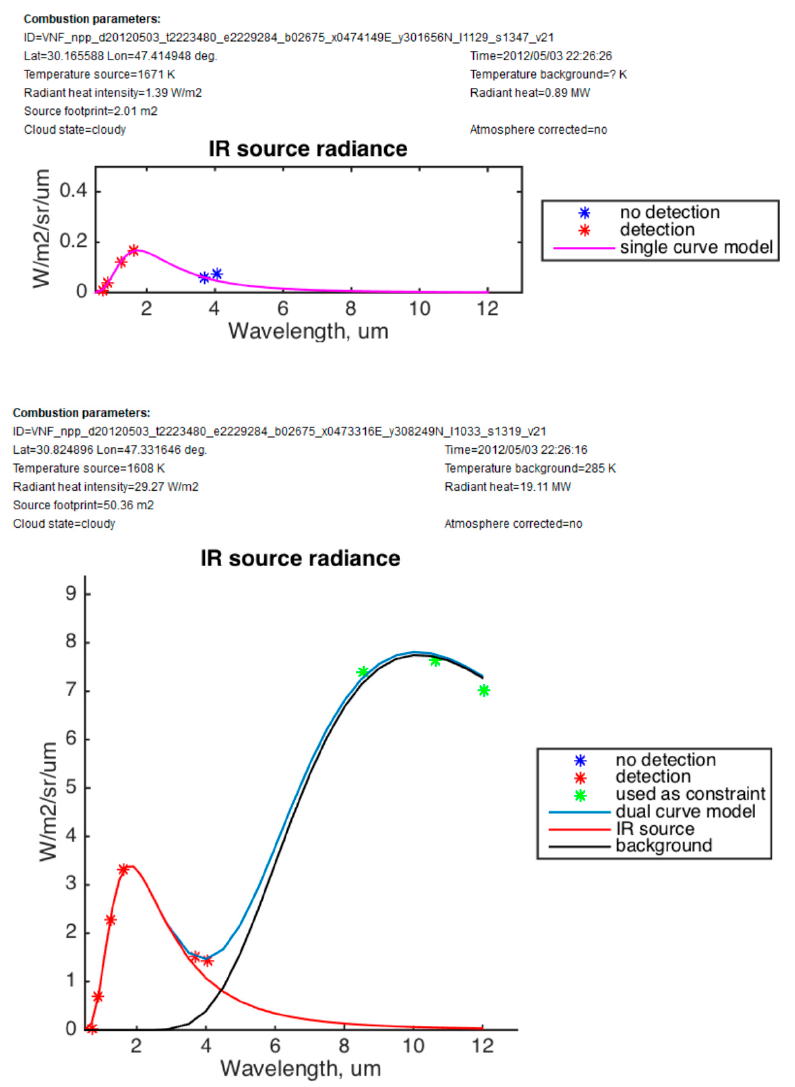
Figure 2. Two types of the spectral fitting in VNF. Single heat source spectrum is fitted when no signal detected in MWIR bands ( top ). Sum of the heat source and the background fitted when MWIR signal detected ( bottom ).